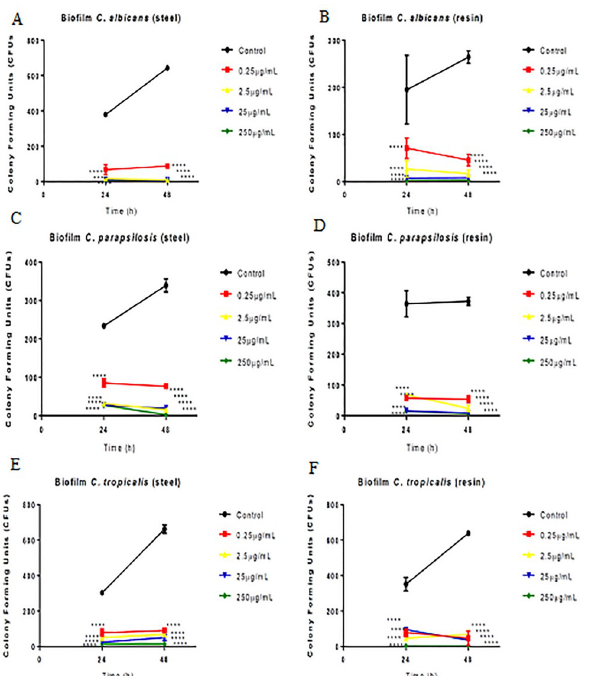
Fig 4. Effect of green propolis extract on biofilm formation by C . albicans , C . parapsilosis , and C . tropicalis on the surface of dental materials (acrylic resin and steel). Effect of extract against Candida spp. according to time and material. � p < 0.05; �� p < 0.01; ��� p < 0.001; � p < 0.0001.